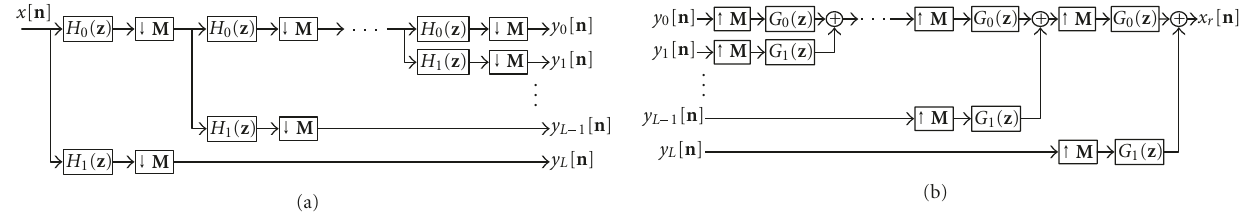
Figure 2: The structure of an L -level octave-band filter bank: (a) analysis side, and (b) synthesis side.